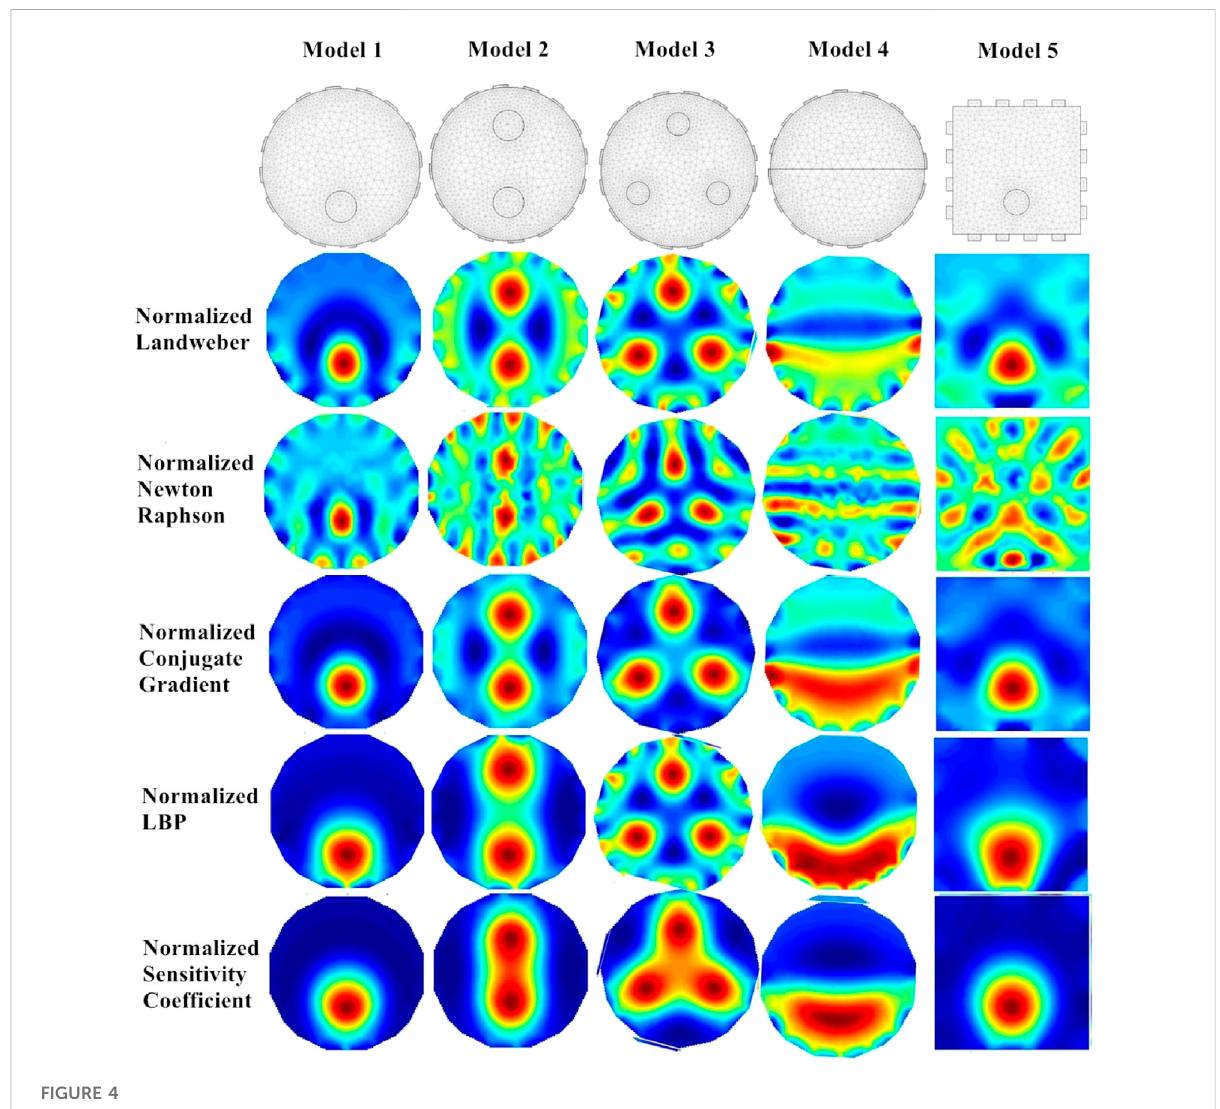
FIGURE 4 Reconstructed image after